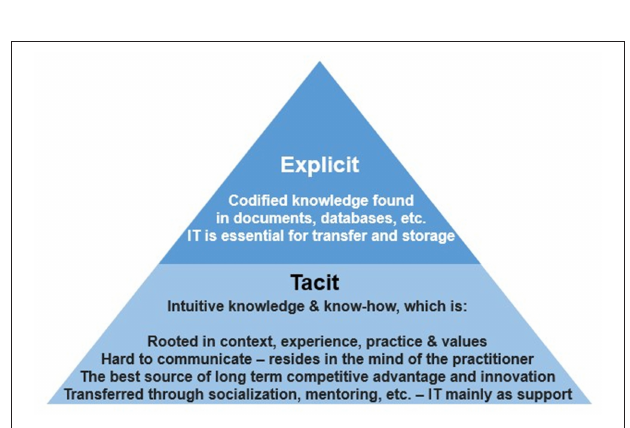
FIGURE 3 | Knowledge